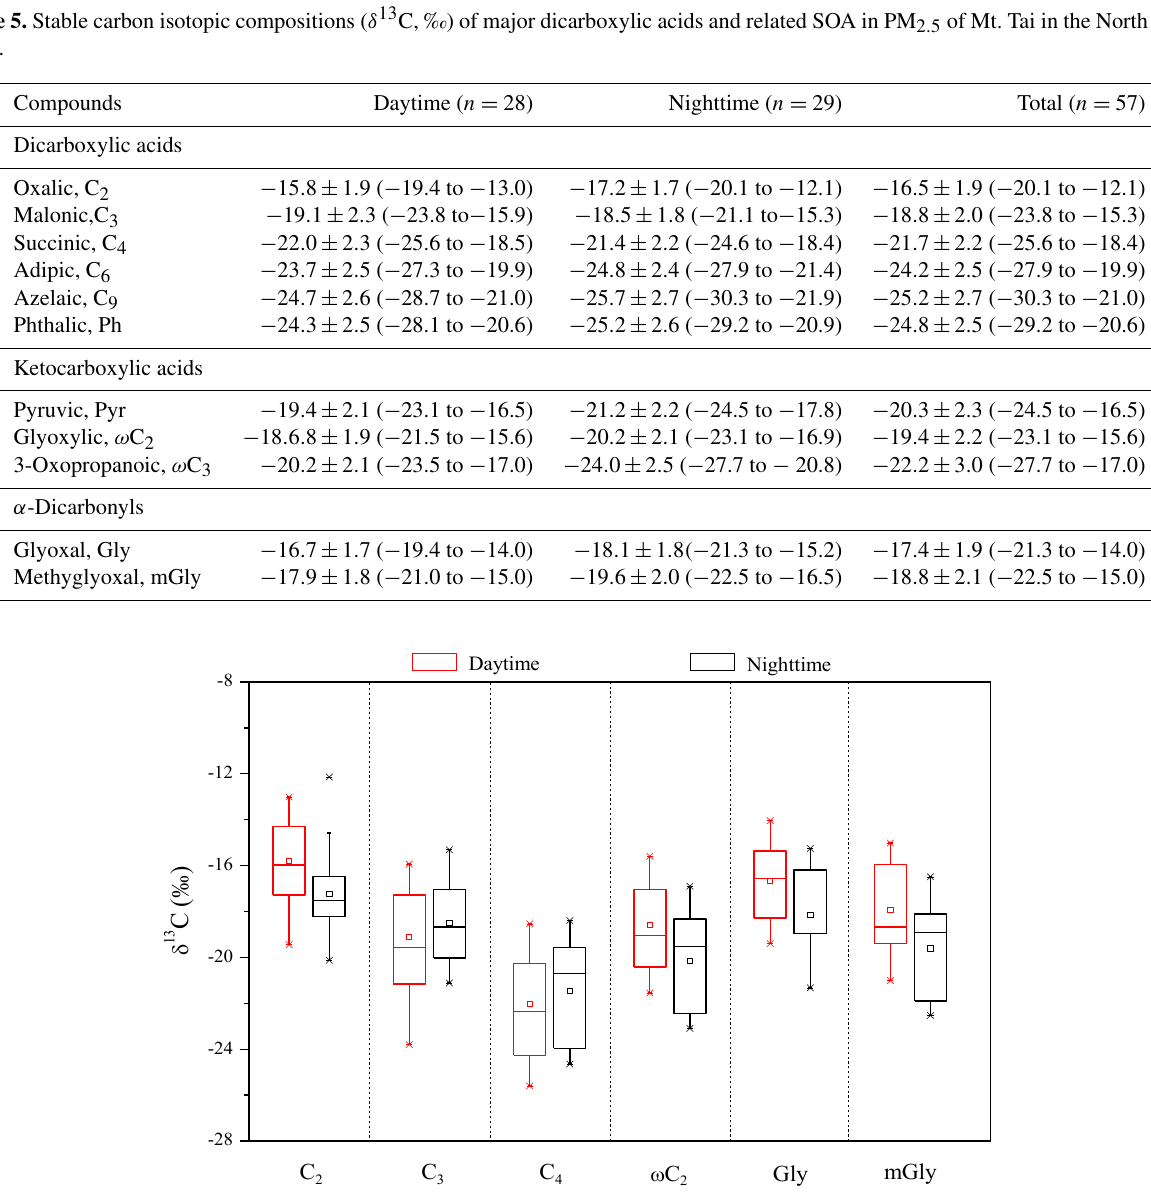
Figure 7. Diurnal variations of stable carbon isotope composition of low molecular weight dicarboxylic acids (C 2 − C 4 ), the smallest keto- carboxylic acids ( ω C 2 ) and α -dicarbonyls (Gly, mGly) in PM 2 . 5 collected at the summit of Mt. Tai during the